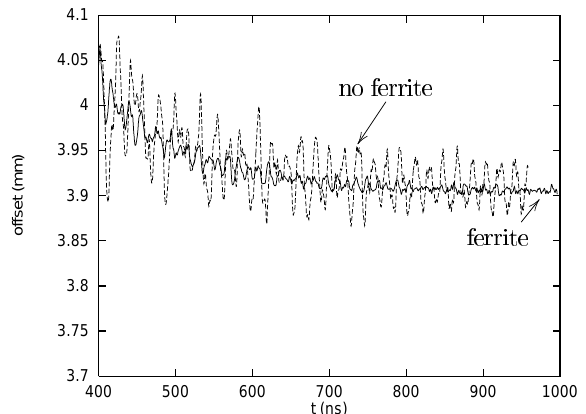
FIG. 12. Comparison of beam centroid motion with and without ferrite-ring damper.